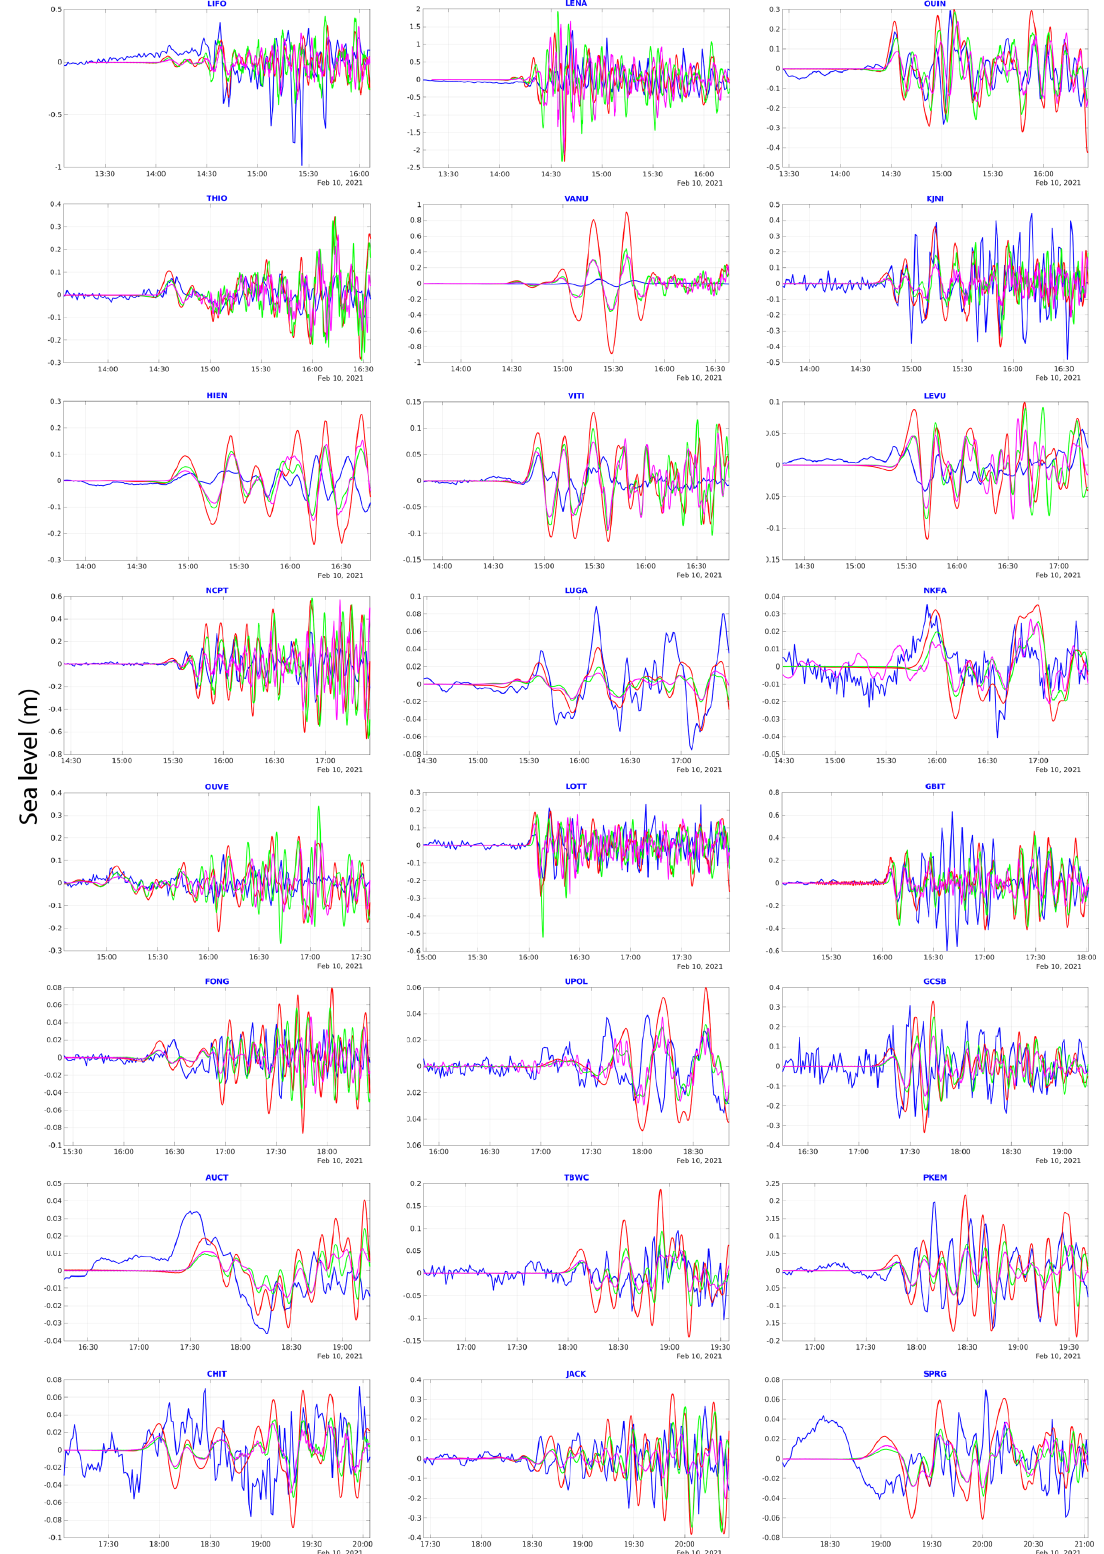
Figure 9. Simulation results obtained with three different seismic source models compared to 24 coastal gauge records: uniform slip model (red), non-uniform slip model from waveform inversion (green), USGS finite fault model (magenta), real filtered records